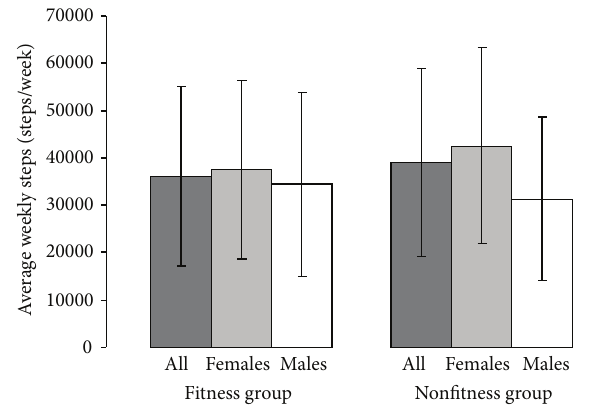
Figure 1: Mean ( ± SD) of average weekly steps for the participants in the fitness and nonfitness group.